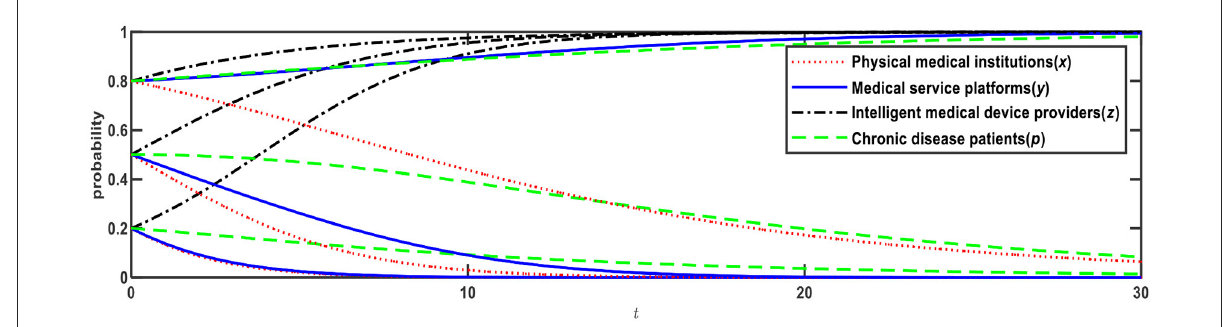
FIGURE2 Evolution of E3 (0,0,1,0) and E12 (0,1,1,1).